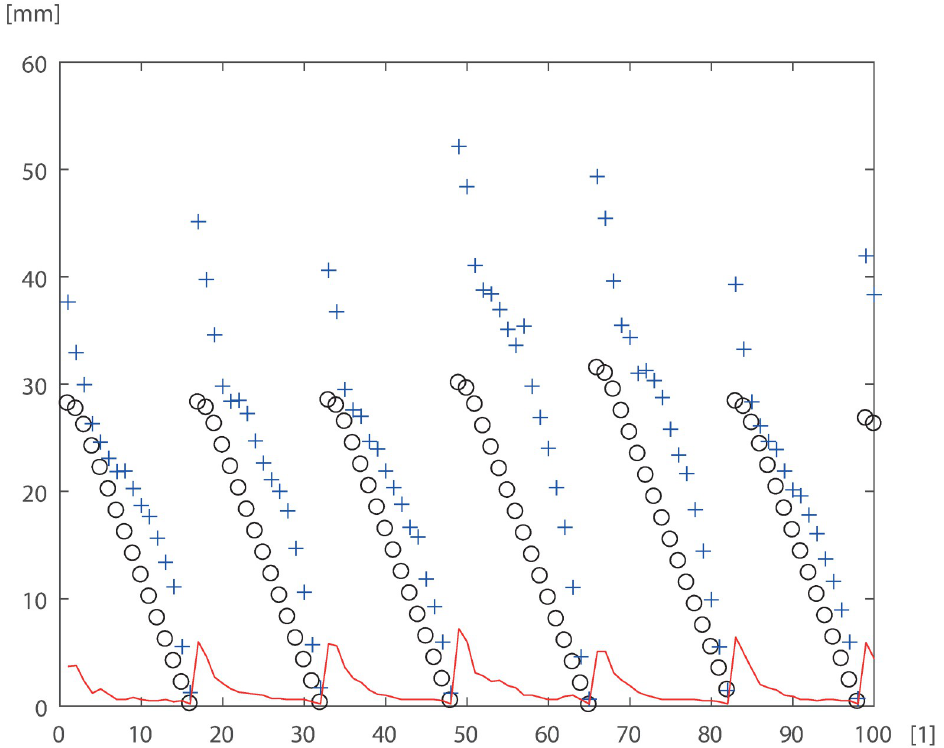
Fig 8. 100 DBT data (black line), STAT 2 (blue line), STAT 1 (cyan line), ANN (red line) for oak. Horizontal axis [1] —identifier of measurement.